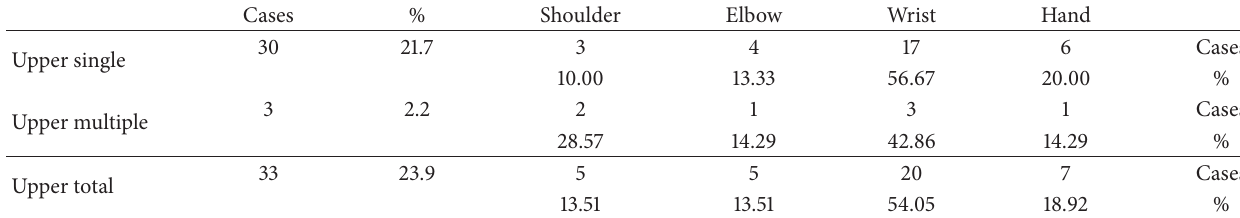
Table 3: Upper limb joints affected by DEH reported in the literature.